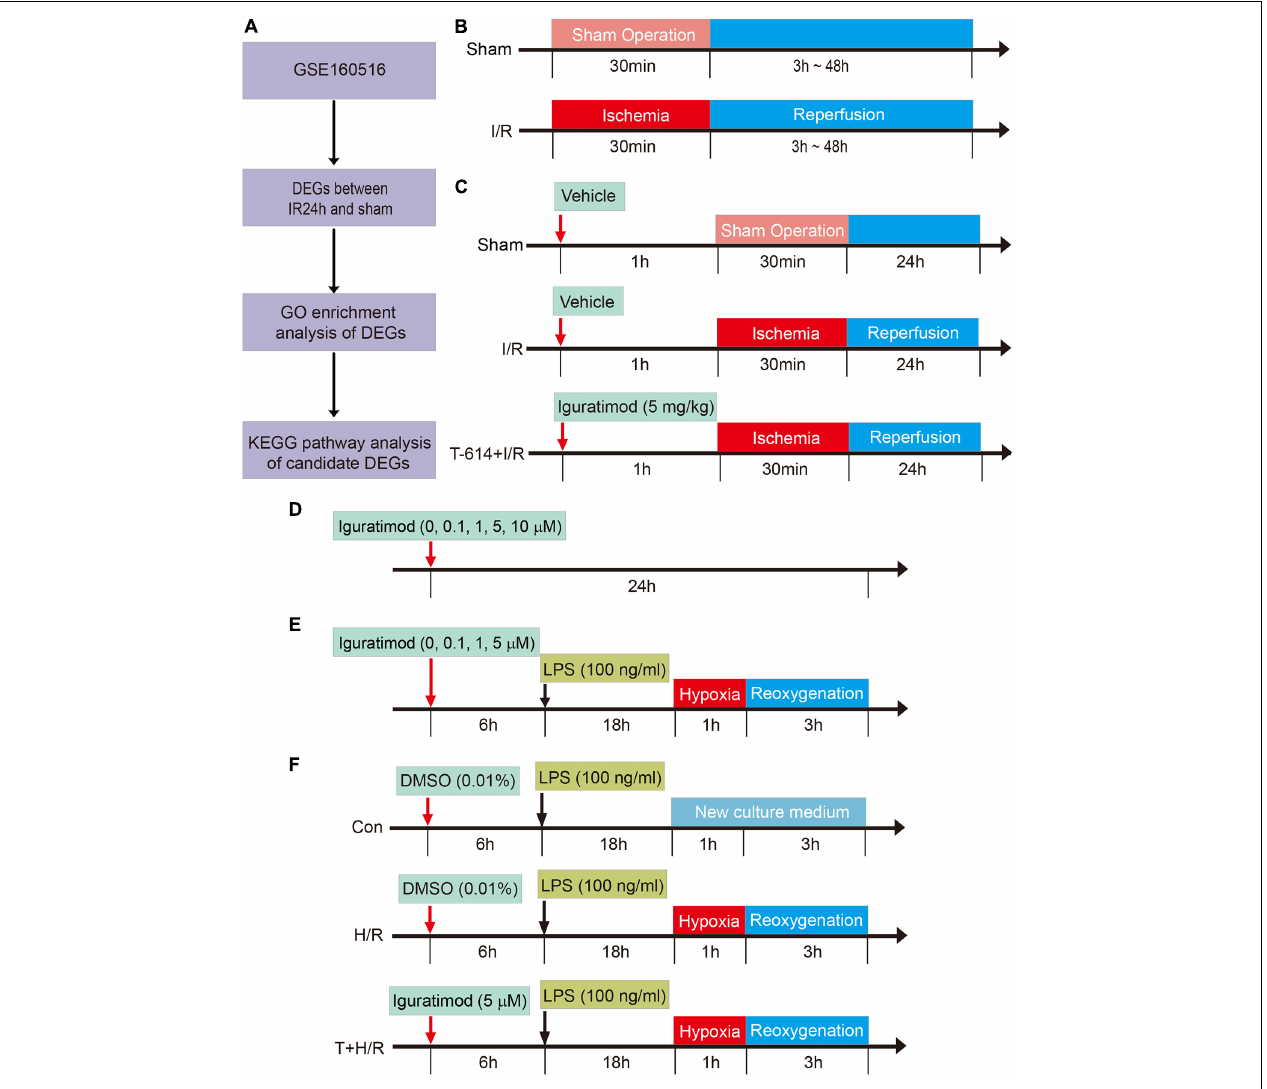
FIGURE 1 | Schematic diagram of the experimental design and major process in the present study. (A) Flow chart of processing data in GSE160516 dataset. (B) Experiment design 1 was performed to demonstrate the time course of changes in mRNA expression of COX2 and NLRP3 after myocardial reperfusion. (C) Experiment design 2 was conducted to investigate the therapeutic effect of Iguratimod pretreatment on myocardial injury induced by I/R and the underlying mechanism. (D,E) Experiment design 3 was carried out to explore the optimal concentration of iguratimod for mitigating H/R injury of primary cardiac fibroblasts. (F) Experiment design 4 assessed the implications of iguratimod on pyroptosis of cardiac fibroblasts in vitro H/R model. I/R, ischemia/reperfusion; H/R,